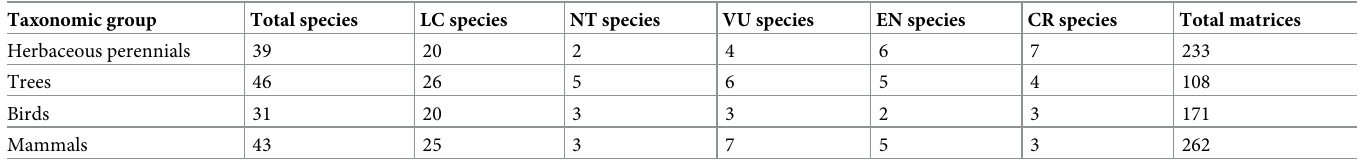
Total number of species included in our analysis across four taxonomic groups and by endangered (IUCN Red List)